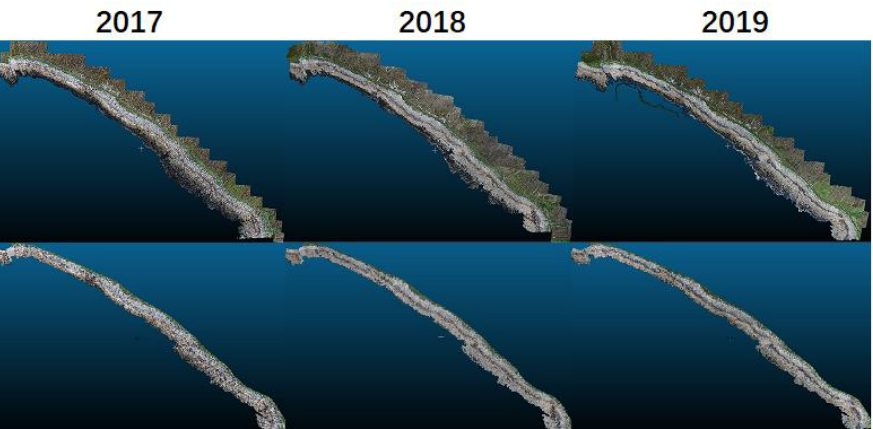
Figure 7. Point cloud models for the three-year span, where the top row shows the original clouds outputted by Pix4DMapper, and the bottom row indicates the clipped clouds.